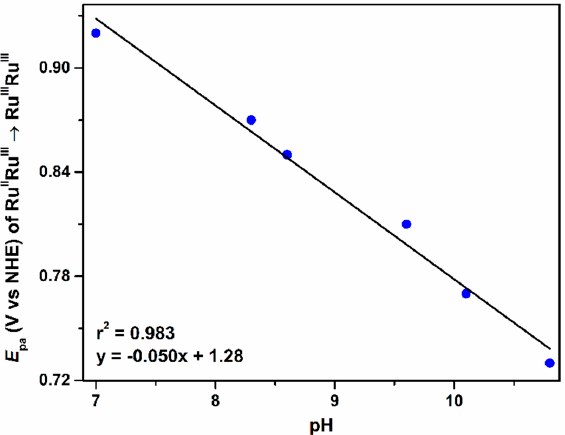
Figure 3. A plot of the anodic peak potential ( E pa ) of the first redox couple vs. the pH of the medium. The voltammograms are recorded in 1.0 mM Na 3 [Ru 2 ( µ -CO 3 ) 4 ] and 0.20 M NaClO 4 aqueous solutions at different pHs with a scan rate of 50 mV·s − 1 under N 2 atmosphere.